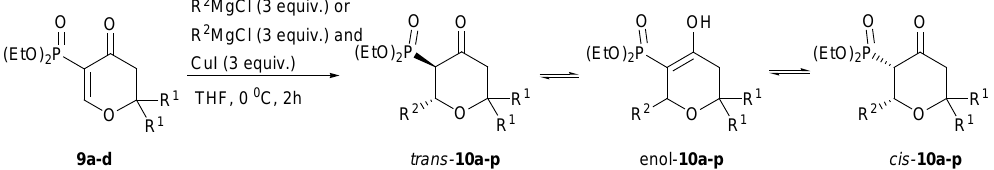
Table 2. Adducts 10a – p and 5-methylidenetetrahydropyran-4-ones 11a – p obtained.